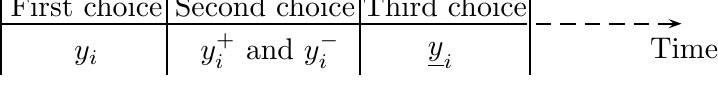
Figure 1. Timeline of eliciting the various components of participant i ’s strategy vector ( y i , y +